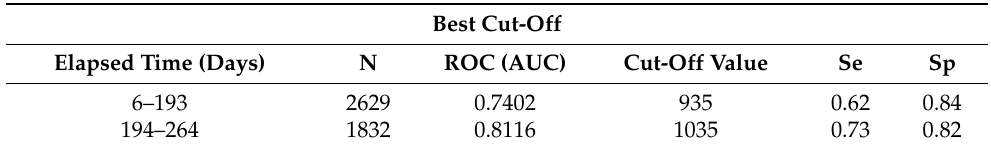
Table 2. Discriminant power of antibody-S IgG titer, evaluated as a function of time elapsed since second vaccination dose.